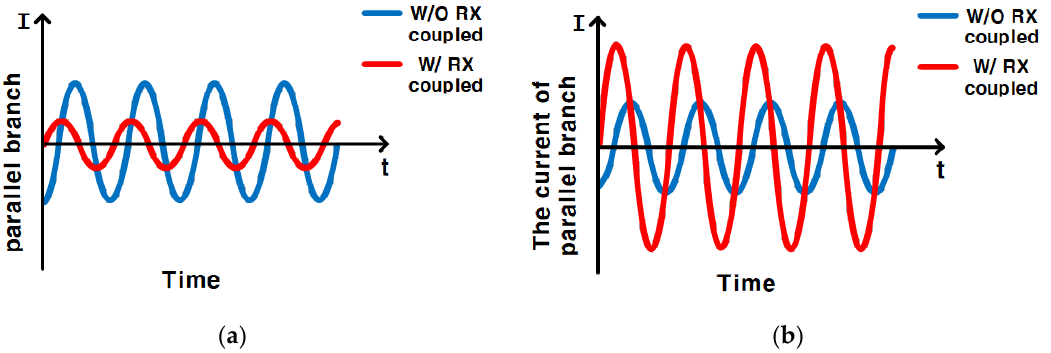
Figure 4. ( a ) When C rx 1 and L rx 1 resonate in the RX, they are the current of the parallel branch not coupled to RX, and the current of the parallel branch coupled to RX; ( b ) When C rx 1 resonates to the parallel branch of L t 1 coupled to RX, they are the current of the parallel branch not coupled to RX and the current of the parallel branch coupled to RX.